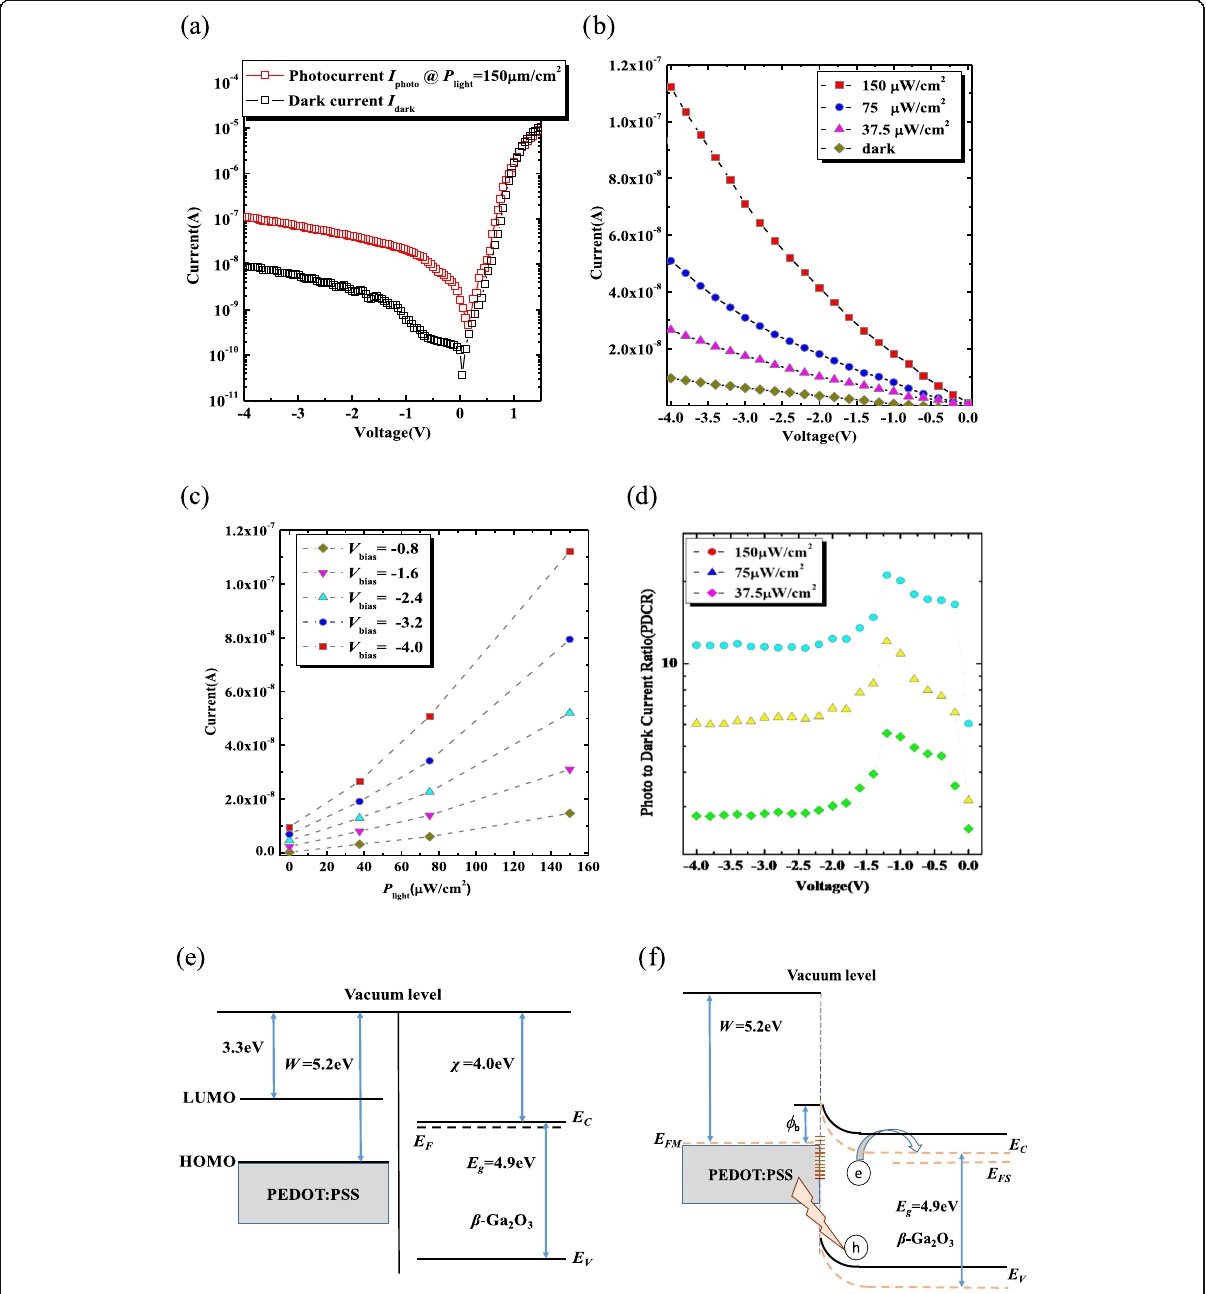
Fig. 4 Relationship between Photocurrent I photo @150 μ W/cm 2 , dark current I dark , and bias voltage V bias ( a ), plots of I photo versus V bias under different P light ( b ), linear I photo as a function of P light ( c ), curves of photo to dark current ratio (PDCR) under different P light ( d ), band diagram of PEDOT:PSS and β -Ga 2 O 3 before contact ( e ), band diagram of PEDOT:PSS and β -Ga 2 O 3 under the reverse bias after contact, the condition without applied voltage and the condition with the reverse bias are shown by the solid line and the dashed line, respectively ( f